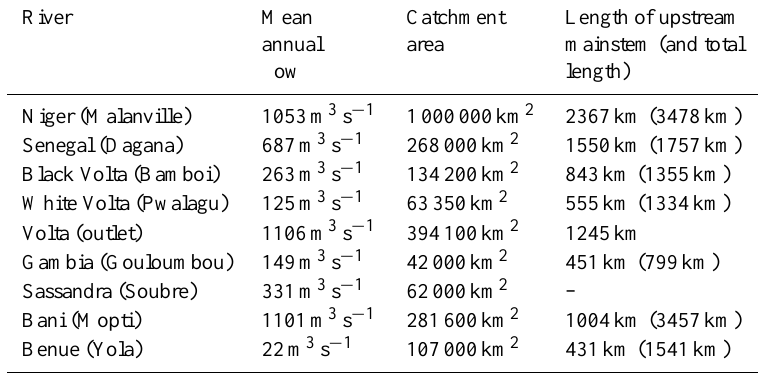
Table 1. Characteristics of the selected rivers. All values come from the Global Runoff Data Centre (GRDC). River Mean Catchment Length of upstream